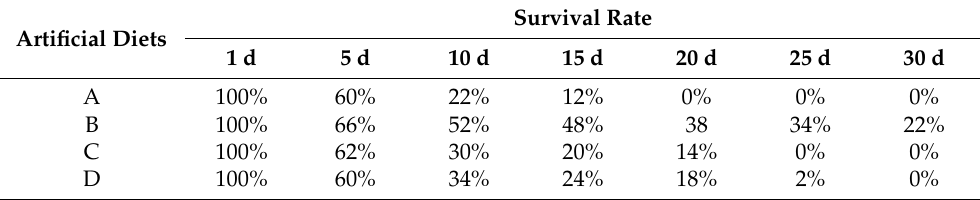
Table 2. Survival rate of Acanthotomicus suncei fed with artificial diets recorded every five days. Artificial